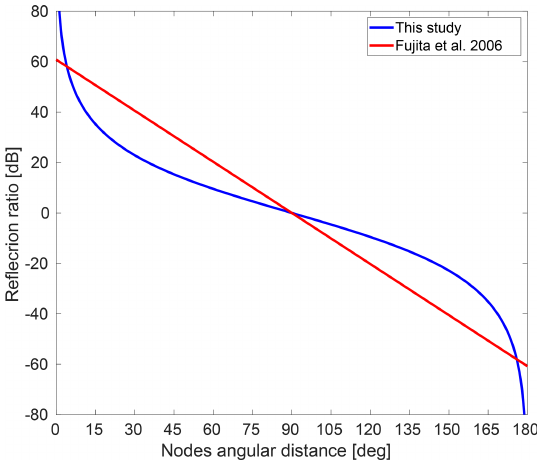
Figure 4. Dependence of reflection ratio on the azimuthal difference between two nodes as determined by Fujita et al. (2006) and through Eq. (13).